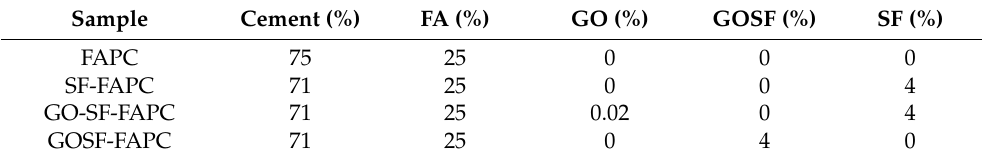
Table 2. The dosages of different materials in experiment 1.